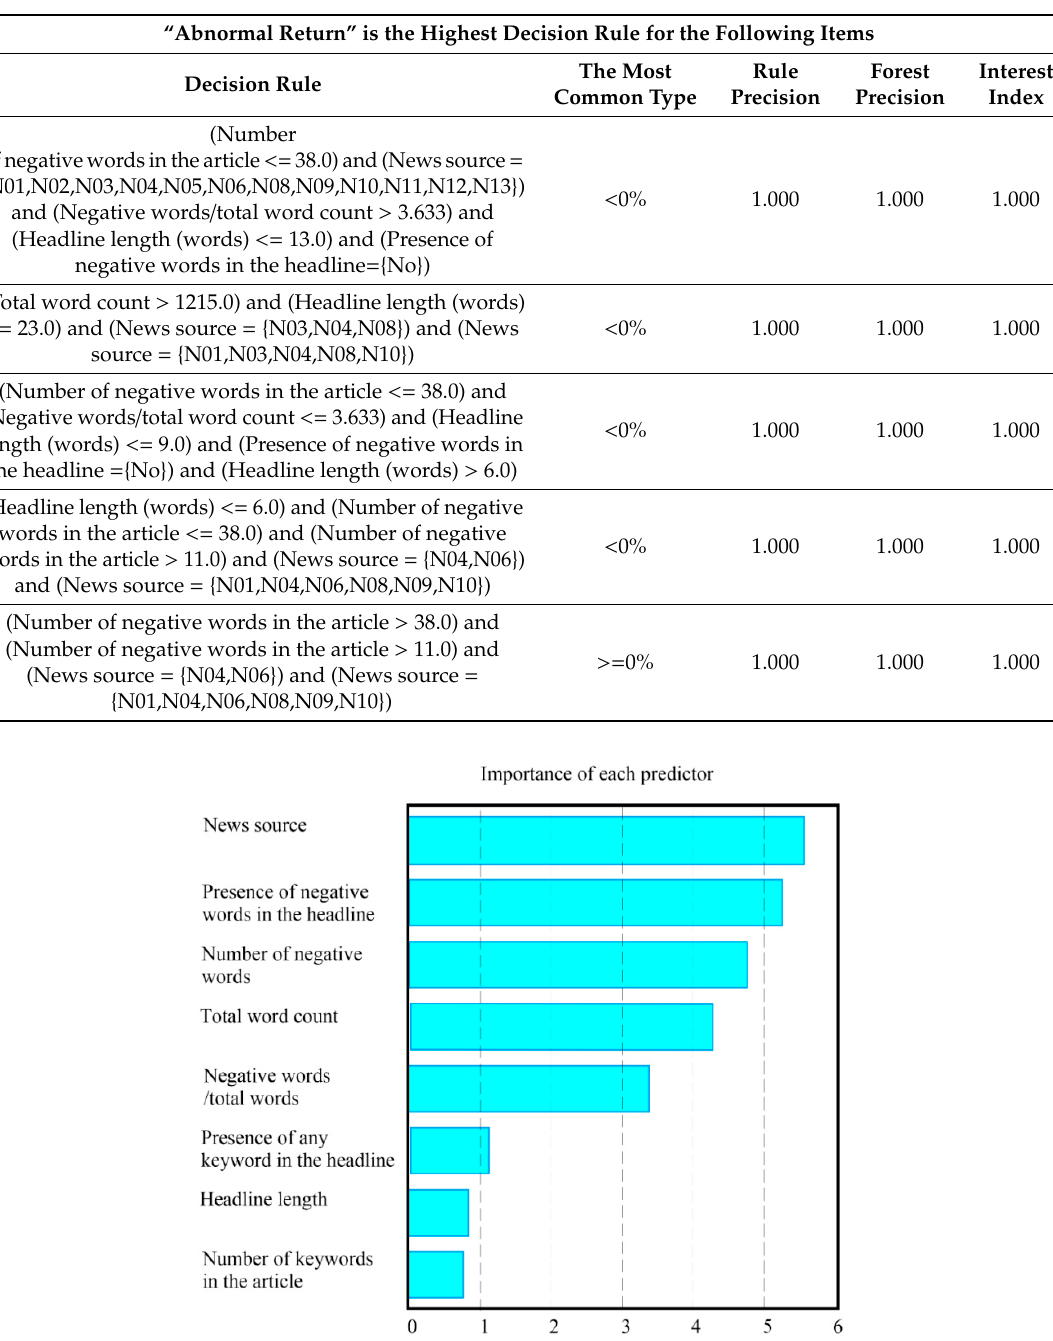
Table 12. The decision rules in the random forest.